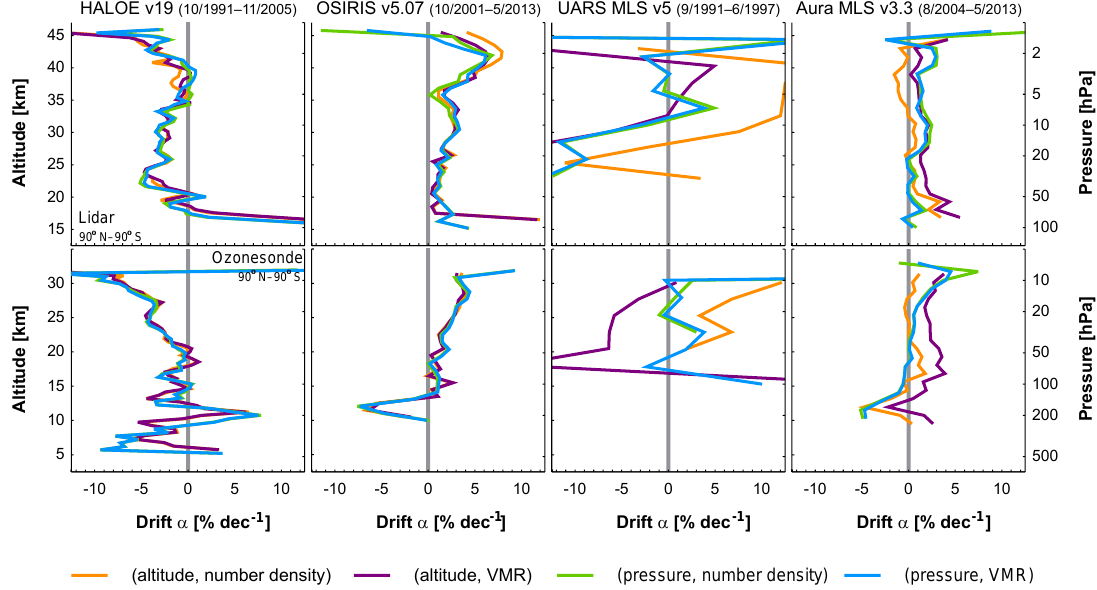
Figure 9. Dependence on profile representation of the network-averaged drift ¯ α of four satellite data records from comparisons to lidar (top row) and ozonesonde (bottom). The satellite profiles are converted using the auxiliary information provided in the respective data files. The Supplement contains the results for all satellite